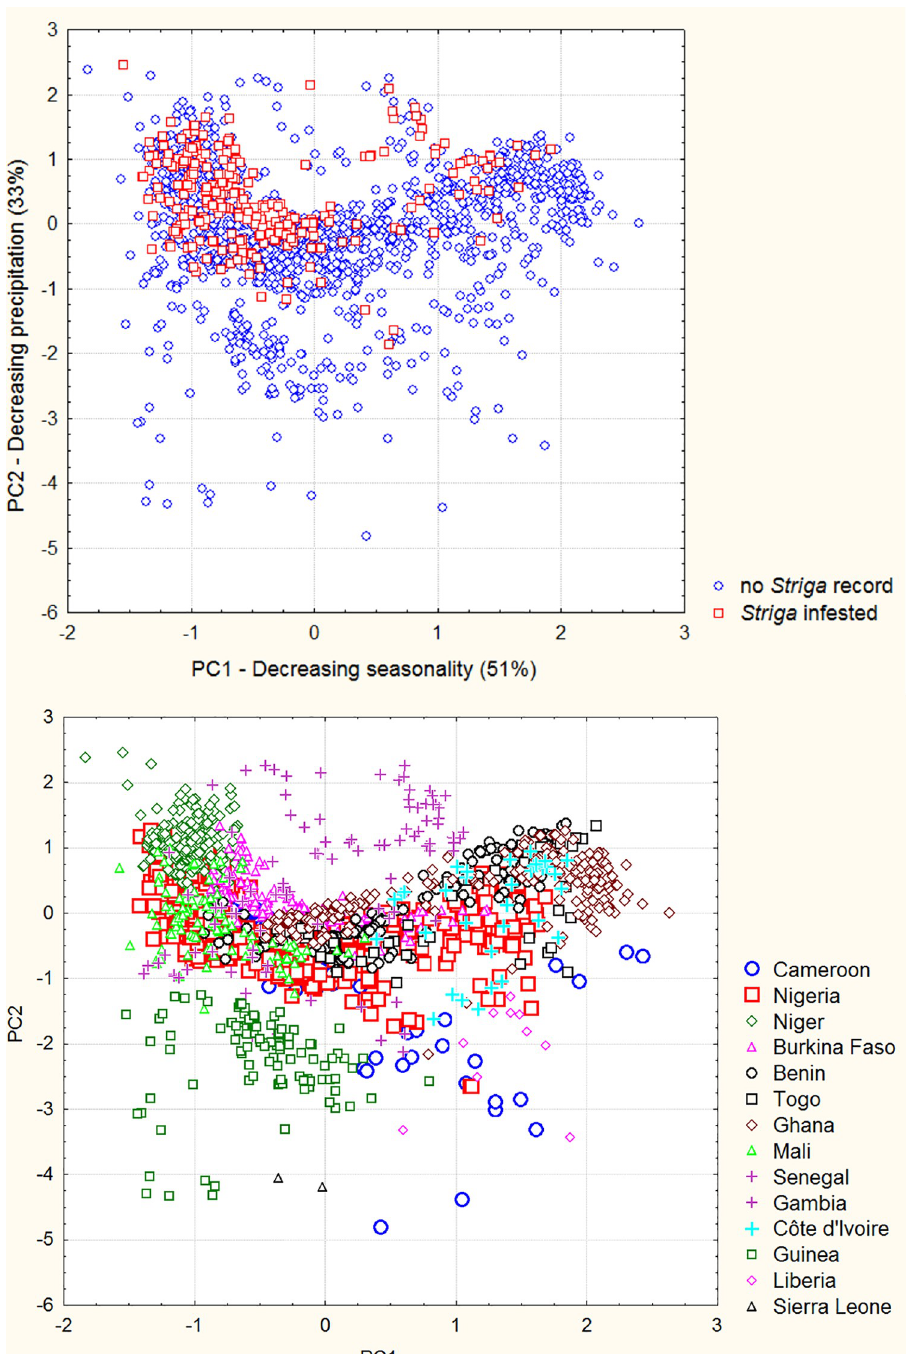
Fig 2. Principal component analysis (varimax normalized rotation) of cultivated cowpea ecoclimatic envelope. Dispersion of datapoints in the principal plane contrasting ( A ) reported infestations of the crop or ( B ) observations from distinct